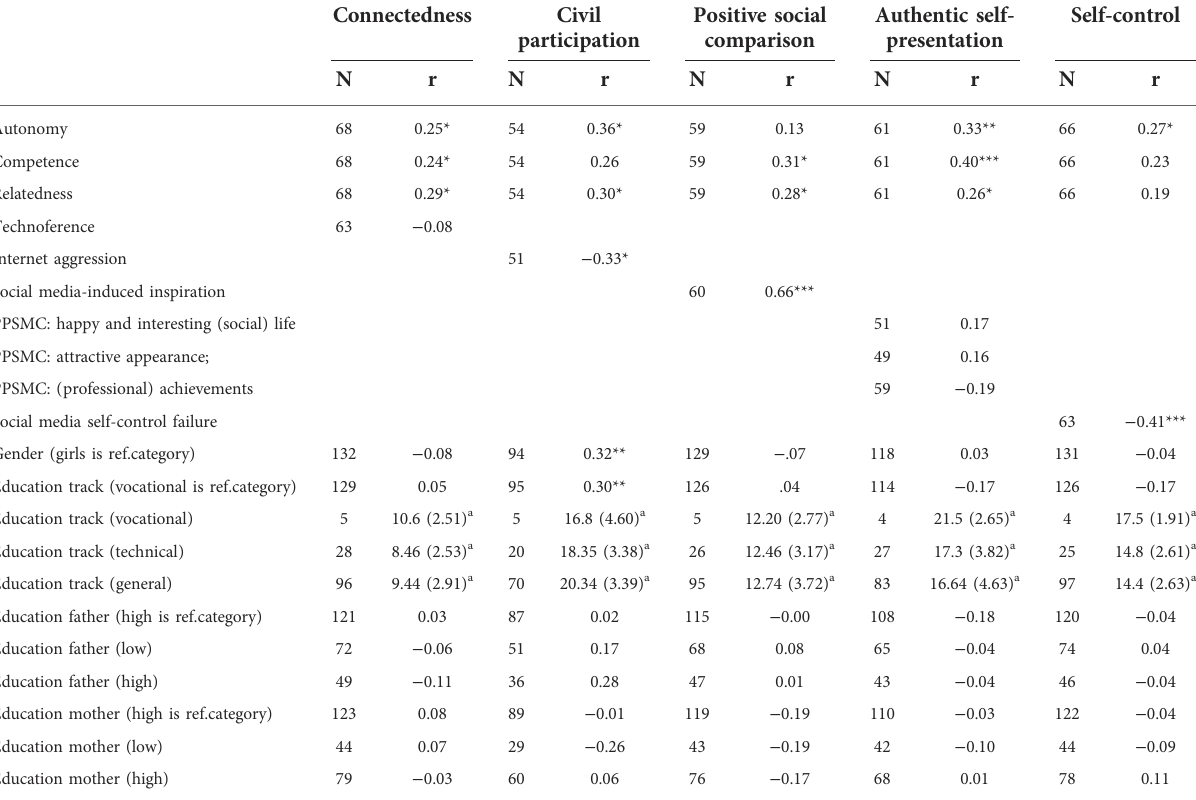
TABLE 2 DFSA construct validity and correlations with demographic variables (study